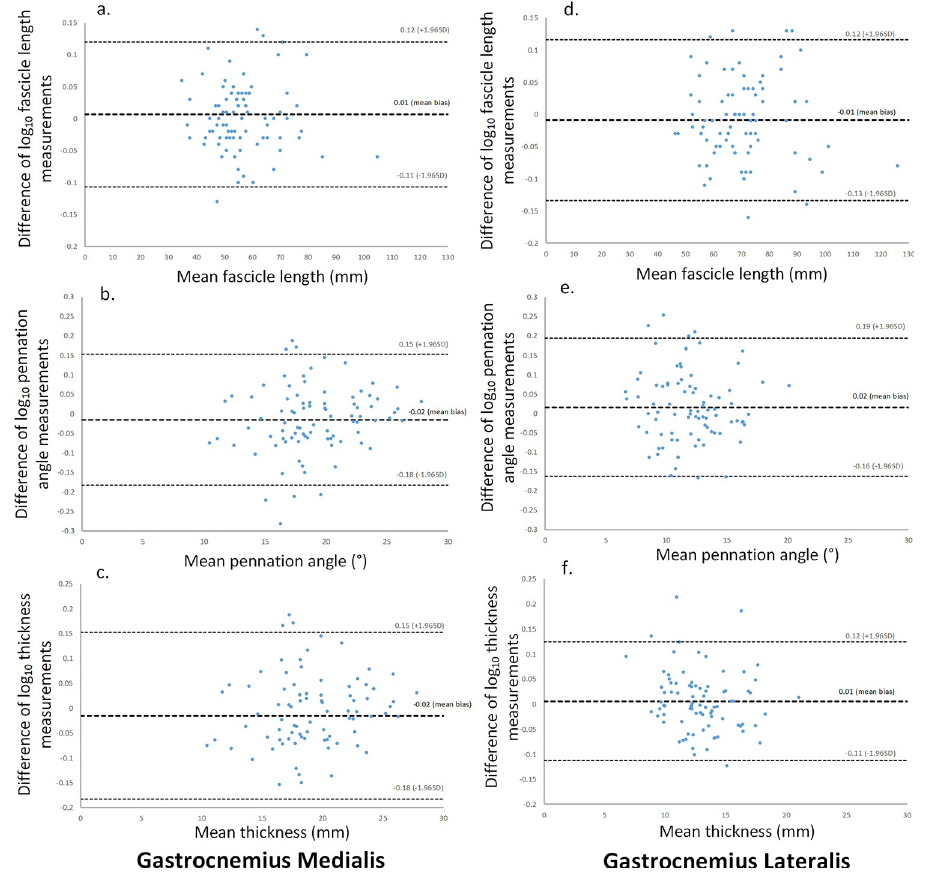
Fig 5. Inter-rater-test-retest Bland-Altman plots of the differences of log-transformed measurements between test session 1 and test session 2 in relation to the mean of test session 1 and test session 2 measurements. Dashed lines indicate the mean bias and the upper and lower 95% limits of agreement. Fascicle length, pennation angle, and muscle thickness measurement comparisons for the gastrocnemius medialis are represented by a. b. and c. respectively, and the gastrocnemius lateralis represented by d. e. and